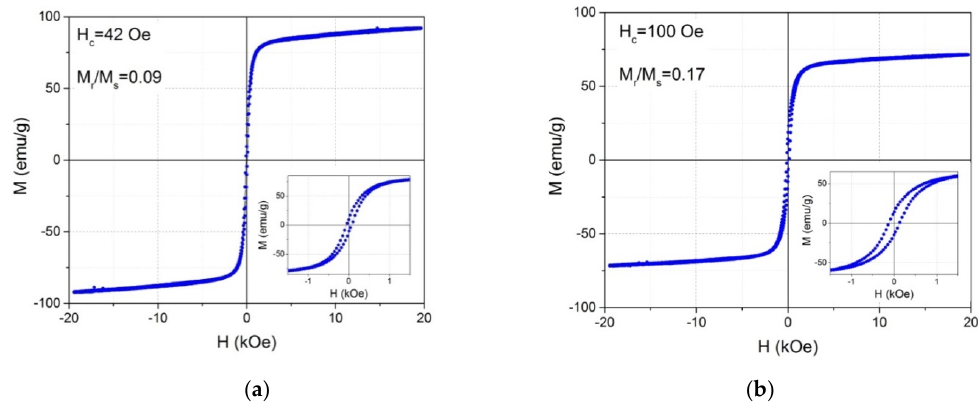
Figure 9. Magnetization loops of the samples Fe 3 O 4 @C ( a ) and Fe 3 O 4 @C@C ( b ) measured at room temperature. Insets: the same in lower magnetic field. M s = 92.8 emu/g ( a ), 72.3 emu/g ( b ).